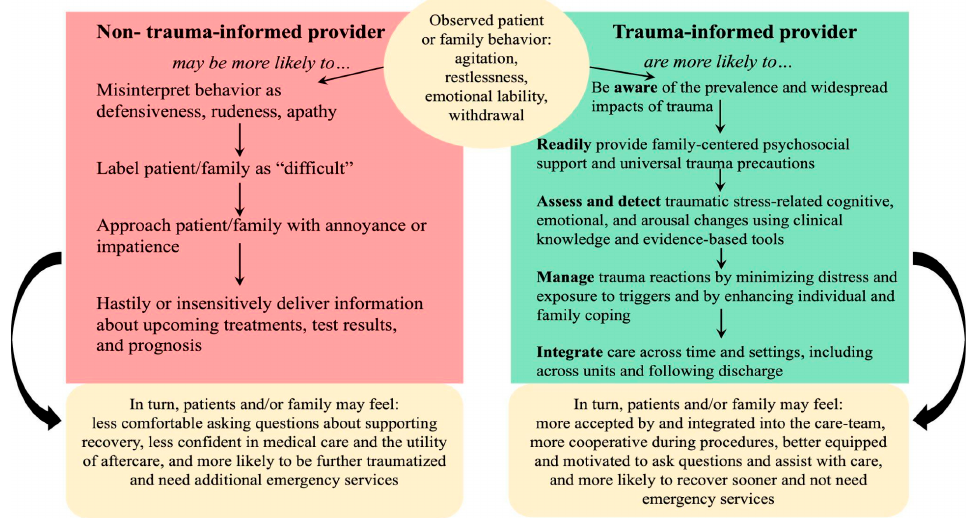
Figure 1. Differential potential reactions and outcomes in response to signs of patient or family traumatic stress.